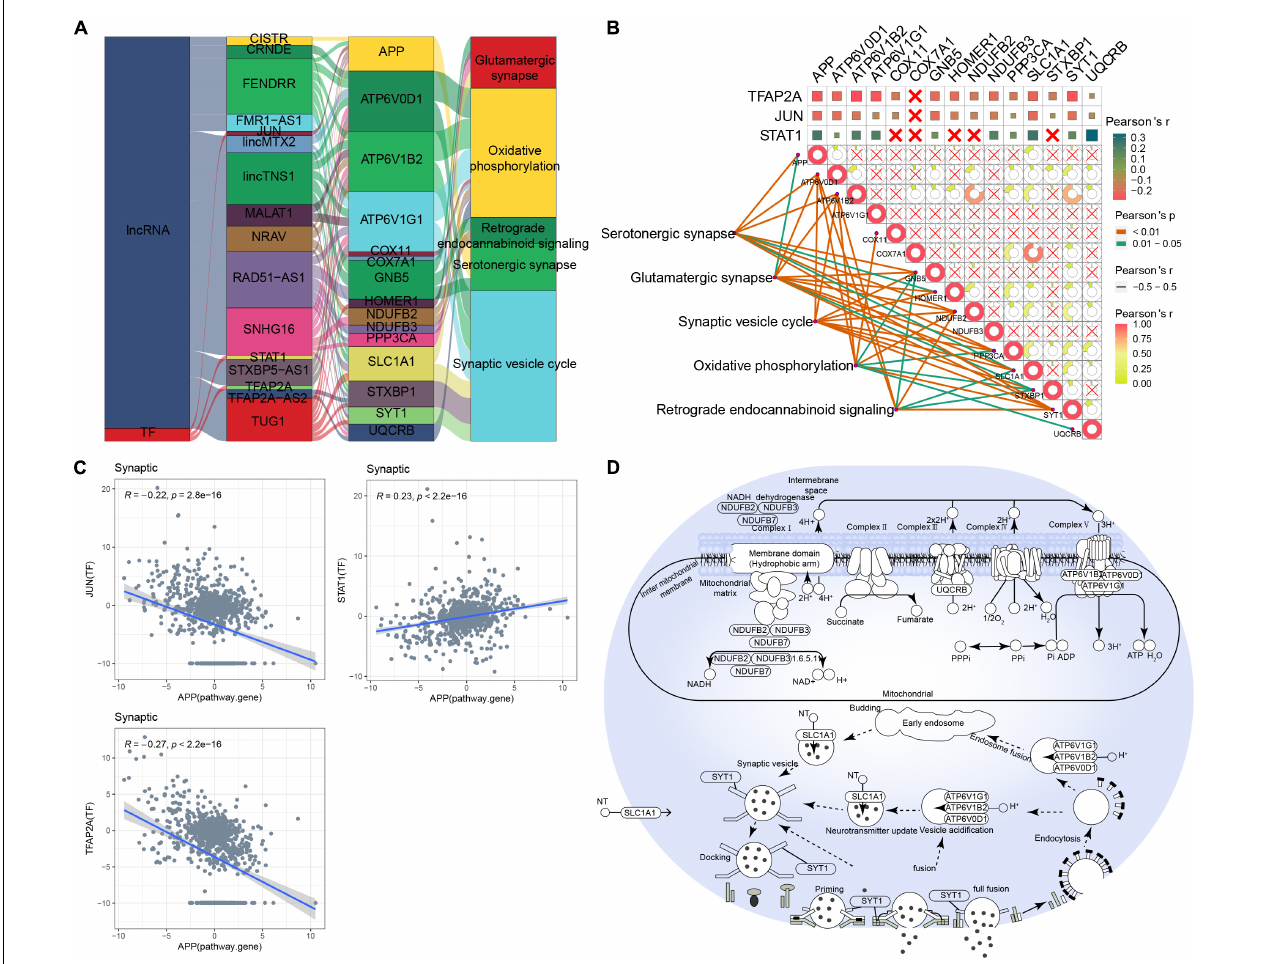
FIGURE 4 | Potential regulatory mechanism of synaptic-type Alzheimer’s disease (AD). (A) Sankey diagram showing the pathways of synaptic-type AD regulated by long non-coding RNAs (lncRNAs) and transcription factors (TFs) identified by the RNAInter and TRRUST databases. (B) Correlation pathway diagram of